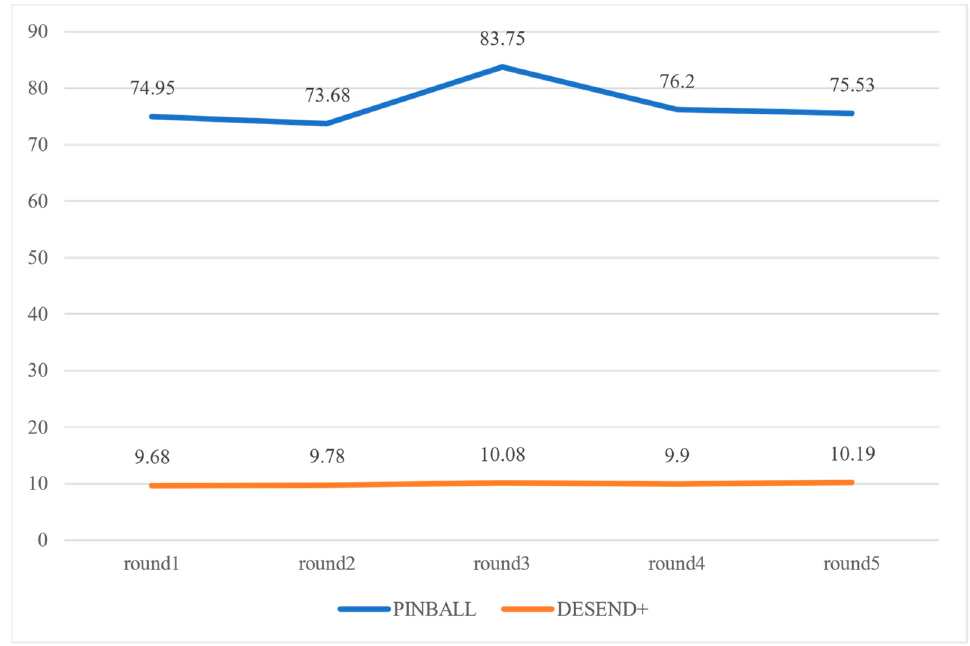
Figure 13. Time consumption comparison.